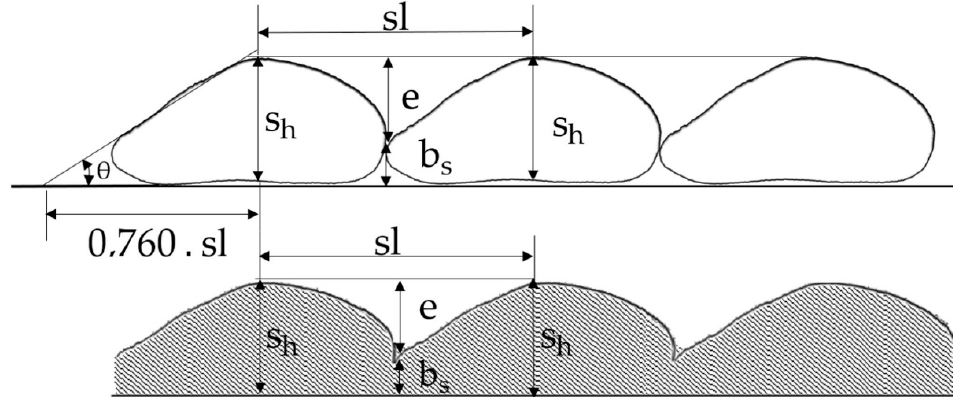
were surveyed and composed a database containing the dimensions shell length (sl), base shell (bs), shell height (sh) and the angle detachment ( θ ) for each individual. Thus, it was possible to develop Equations (1)–(4) (new equations). From these data, using the Excel spreadsheet, we obtained a curve that relates the angle “ θ ” with the “sl” and then adjusted Equation (1), which had a coefficient R² = 0.9935. It was observed by measuring GM husks that the dimension formed between the vertex of the triangle and the top of the bark has a constant ratio of “0.76 · sl” (Figure 4). Thus, it was obtained from trigonometric relation Equation (2), which provides the dimension “sh”. Dimension “bs,” also obtained by measuring GM shells, corresponds to 38% of shell length “sh” and can be calculated by Equation (3). The “e” corresponds to 62% of the dimension “sh” and can be calculated by Equation